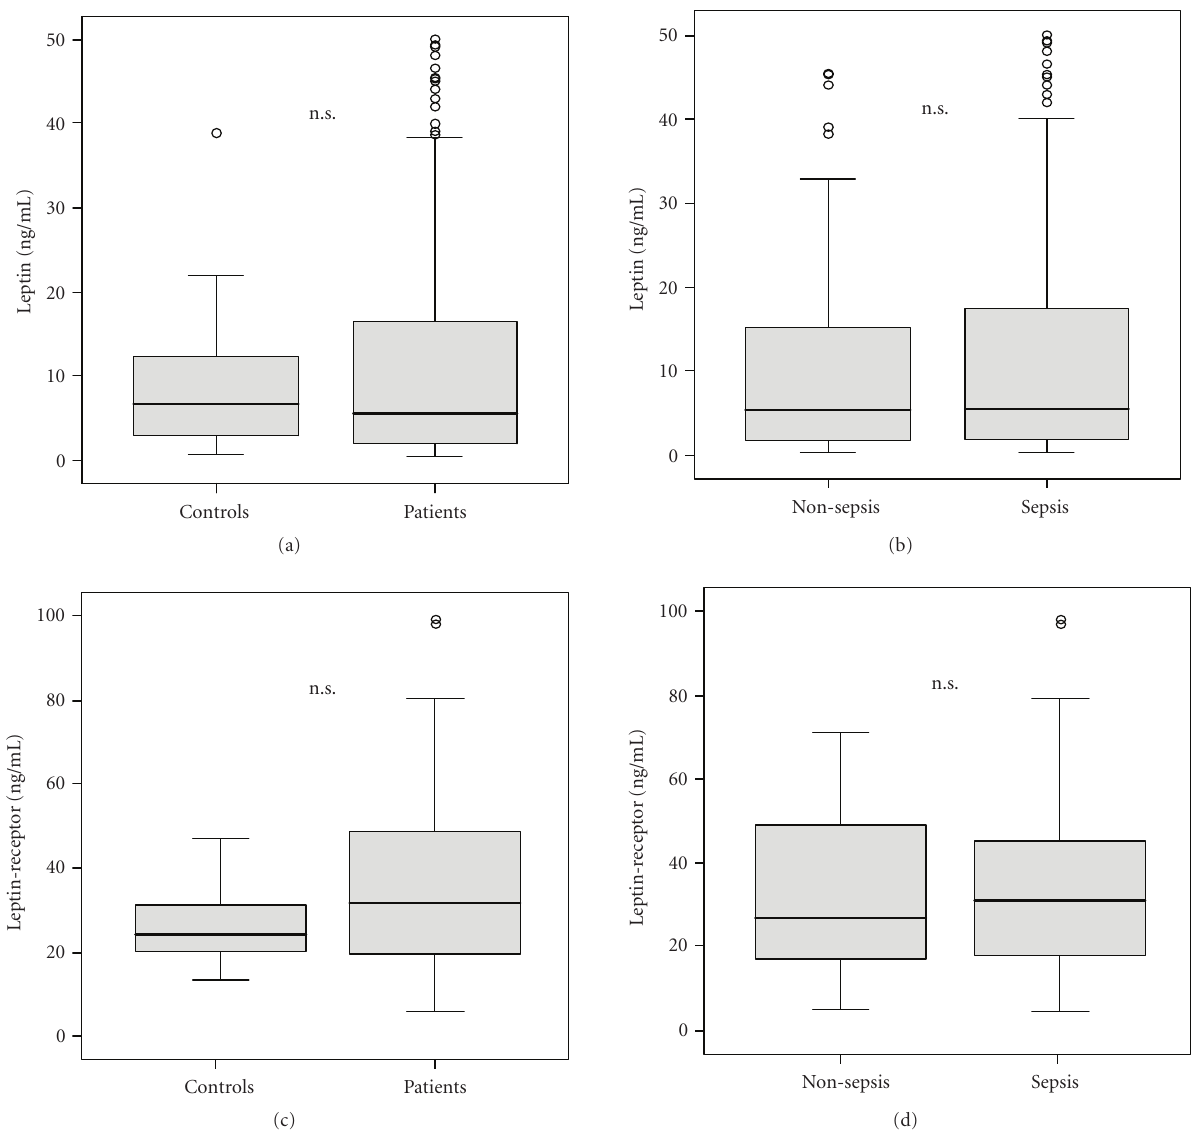
Figure 1: Serum leptin and leptin-receptor concentrations in critically ill patients. (a) Serum leptin levels are not di ff erent in critically ill patients ( n = 137, median 5.5ng/mL, range 0.4–49.6) as compared to healthy controls ( n = 26, median 6.6ng/mL, range 0.7–38.6). (b) No significant di ff erences are detected between ICU patients with sepsis ( n = 95, median 5.5ng/mL, range 0.4–49.6) and nonseptic etiology ( n = 42, range 5.4 ng/mL, range 0.4–45.1) of critical illness. (c) Leptin-receptor serum concentrations do not di ff er between critically ill patients (median 31.5 ng/mL, range 5.7–126.9) and healthy controls (median 23.9ng/mL, range 13.1–46.4). (d) No di ff erence in serum leptin-receptor concentrations can be observed between patients with (median 31.8ng/mL, range 5.7–126.9) or without sepsis (median 29.0ng/mL, range 7.4–124.7) at admission to the ICU. Box plot are displayed, where the bold line indicates the median per group, the box represents 50% of the values, and horizontal lines show minimum and maximum values of the calculated nonoutlier values; asterixes and open circles indicate outlier